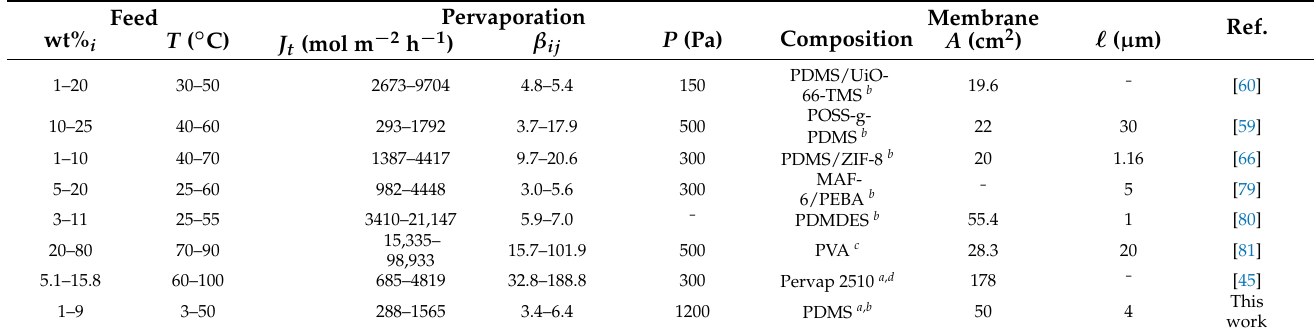
Table 4. Experimental pervaporation